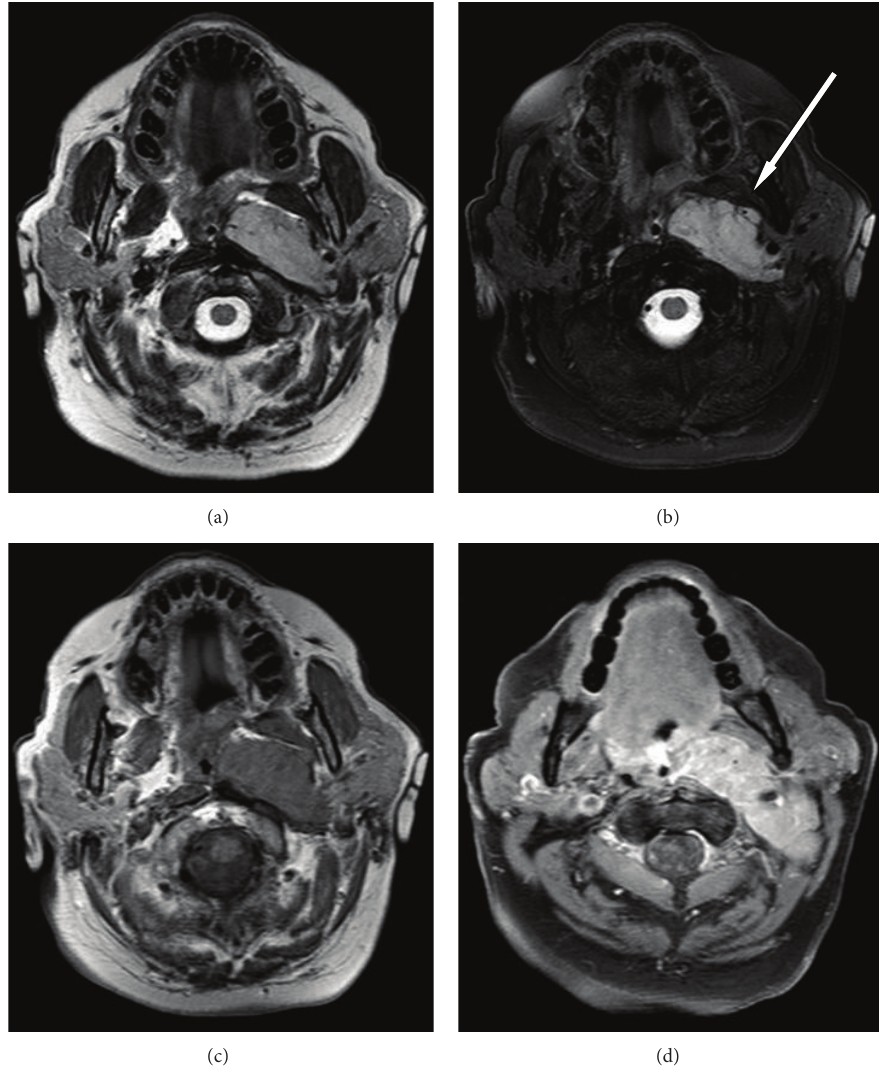
Figure 2: MRI evaluation. (a-b) Axial T2-weighted MRI image (TSE, 4000/80 [TR/TE]) and T2-weighted fat saturated (SPIR 3640/70/200 [TR/TE/TI]) show a well-defined hyperintense mass which determinates bulging of the pharyngeal wall; (c) axial T1-weighted image (265/7.5 [TR/TE]) showed an isointense mass compared to the muscle signal intensity; (d) axial T1-weighted image after gadolinium injection evidences an intense and inhomogeneous contrast enhancement of the